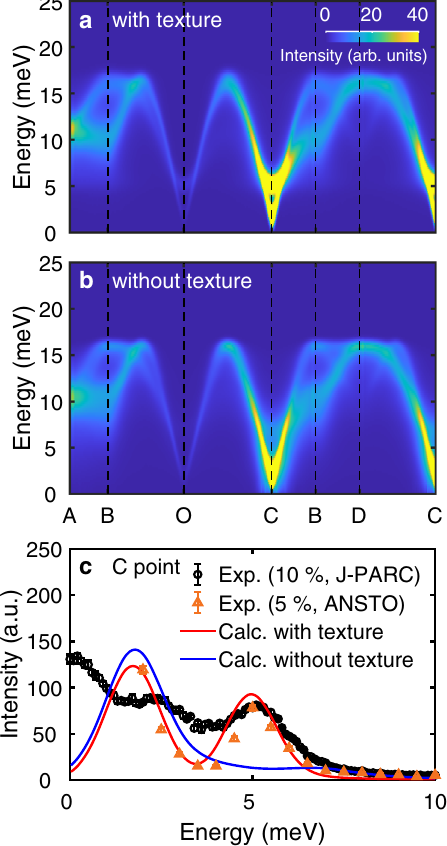
Fig. 4 A role of spin textures in the spin dynamics of h- YMn 1-x Al x O 3 . Theoretical spin-wave spectra of h -YMn 0.9 Al 0.1 O 3 a with vacancies and spin textures, and b with vacancies but without spin textures. c A constant Q -cut at the C point, which demonstrates the suppression of the 5 meV mode in the calculation results without spin texture. Black and orange points are the INS data of h -YMn 0.9 Al 0.1 O 3 and h -YMn 0.95 Al 0.05 O 3 , respectively. Blue and Red solid lines are the constant- Q cuts of a and b . Note that this fi gure ’ s calculation results do not include the effect of data integration along the c ∗ experimental data and the theoretical calculation with the spin texture (Fig. 4c). This result implies that the in-plane spin texture against the non-magnetic impurity.